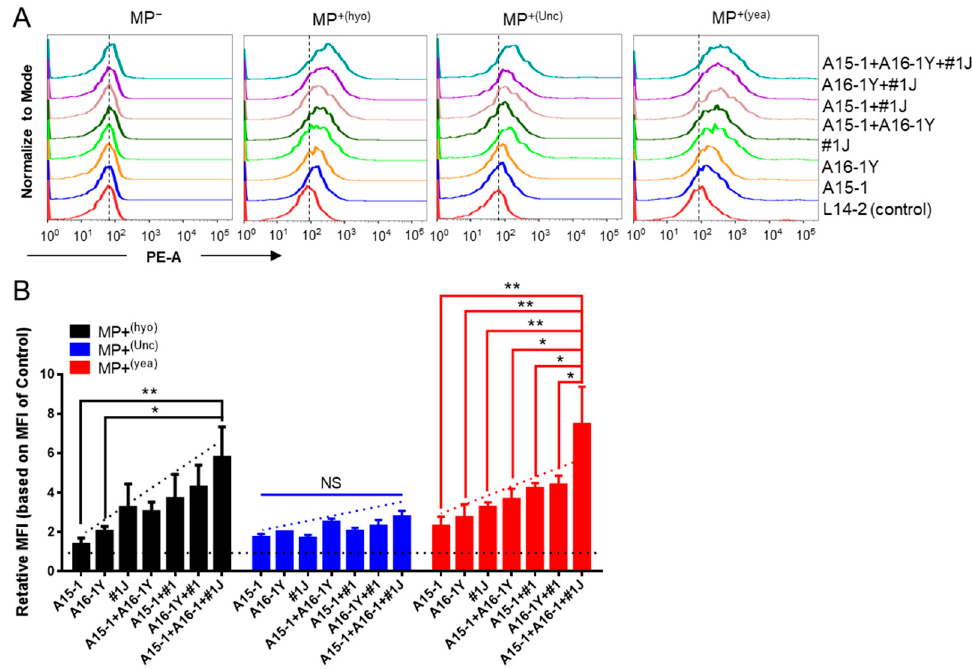
Figure 5. Aptamer cocktail facilitates detection of multiple infection-causing mycoplasma species. The binding ability of the aptamer cocktail is shown for multiple species of mycoplasma-infected cells. ( A ) Binding tests for single, pairwise, and triple mixed aptamers on multiple species of mycoplasma-infected Jurkat cells by flow cytometry. The concentration of each aptamer in pairwise and triple mixed aptamers was 50 nM. The vertical dashed lines indicate the position of the fluorescence peak of L14-2-bound cells. Data show representative results from three independent experiments; ( B ) Relative MFI of various aptamer-bound cells versus control aptamer-bound cells. The control aptamer is L14-2; the horizontal dashed line indicates the baseline of the normalized relative MFI; the diagonal dashed lines indicate the variation tendency; MP − , mycoplasma negative. MP + (hyo) , M. hyorhinis positive; MP + (Unc) , unclassified mycoplasma negative; MP + (yea) , mixed mycoplasma positive. Data show the mean ± SD of three independent experiments. * p < 0.05, ** p < 0.01, “NS” means not significant.